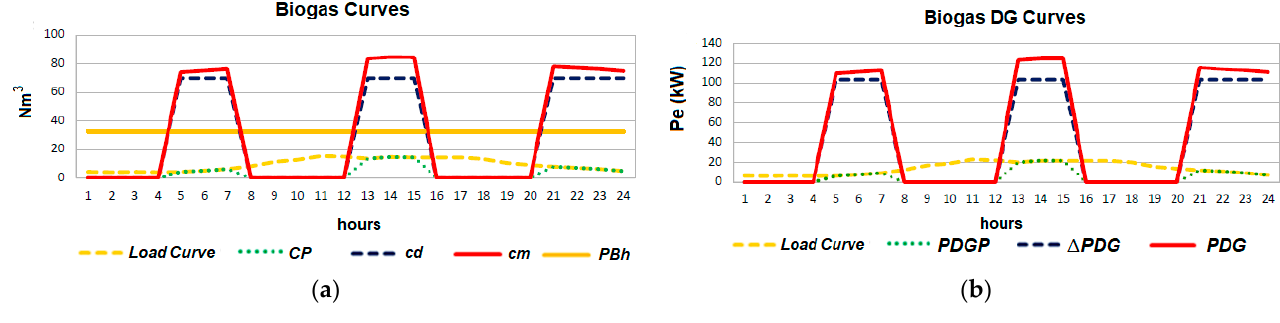
Figure 12. Case 3: ( a ) Biogas curves; ( b ) MOR from biogas DG.